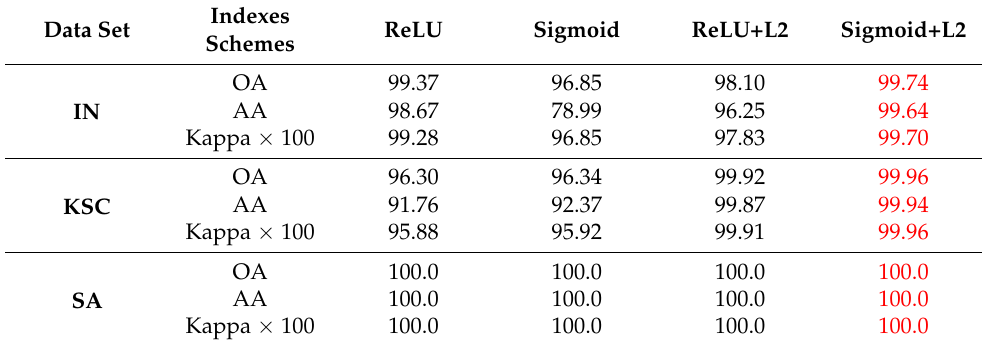
Table 9. The effect of classification scheme for three HSI datasets.